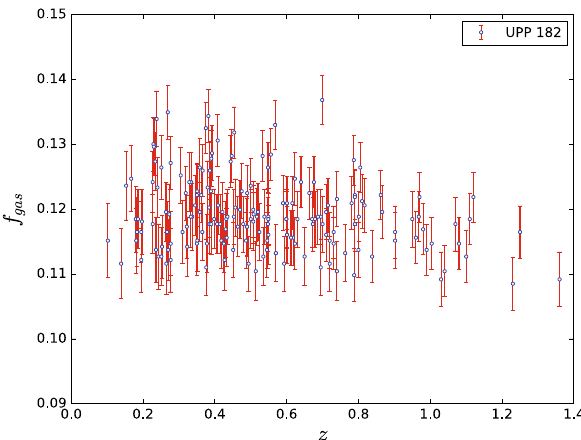
Fig. 1 The gas mass fraction derived from ACTPol measurements [12]. Blue circles with red bars represent central values and correspond- ing 1 σ uncertainties calculated from cluster total mass based on the semi-empirical